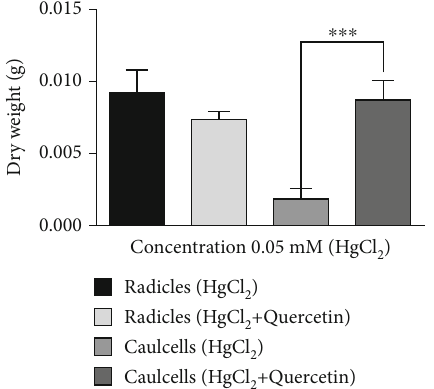
Figure 5: Spectra of pure catechin and associated mercury chloride ) and in at 0.05 mM and 2